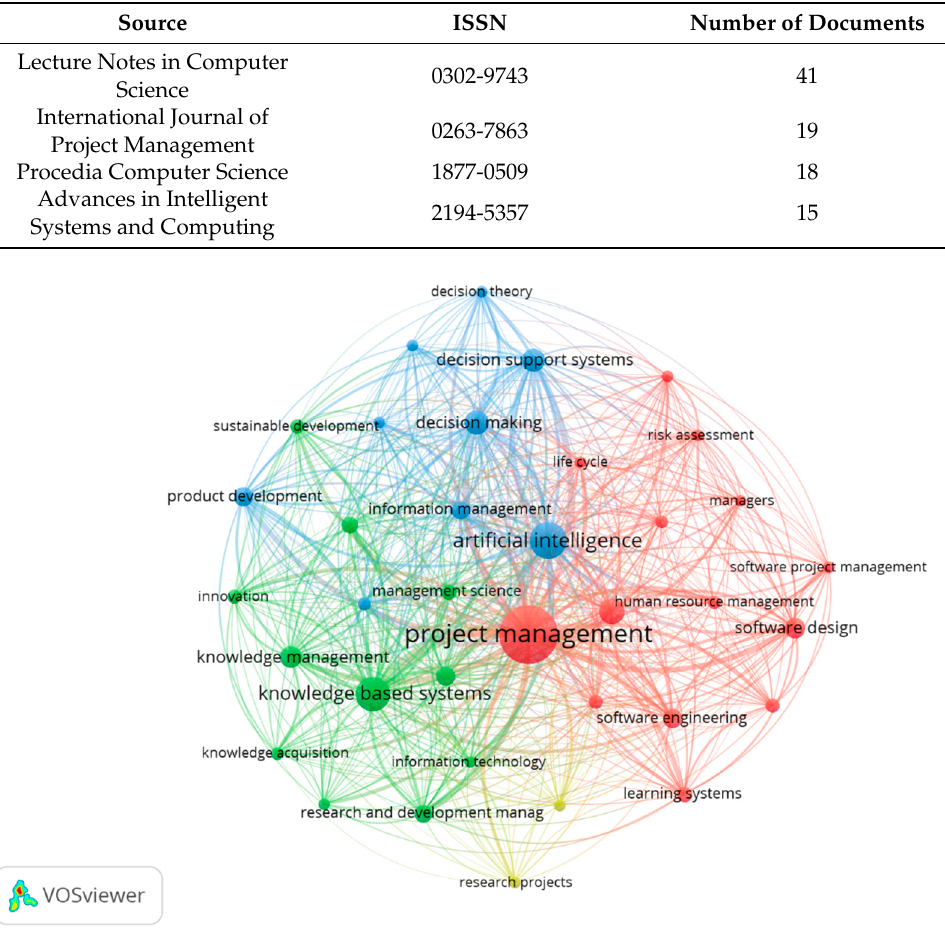
Figure 3. Number of documents by domain. Results by Domain The results obtained in the specific queries of Scopus for each of the domains defined by the PMI are presented below. For each domain, the terms that define each of the clus ‐ ters identified using the VOSviewer software are described, paying special attention to those terms that have not been used as search terms. Figure 4 shows the clusters identified by the VOSviewer software in the results of the bibliographic search in the Stakeholders domain: